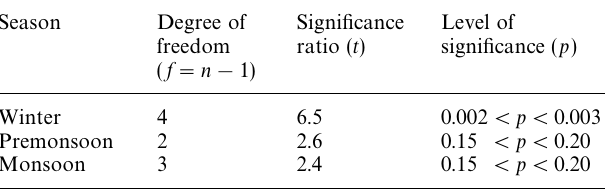
Table 8. Significance ratio ( t ) and level of significance ( p ) Season Degree of Significance Level of freedom ratio ( t ) significance ( p ) ( f " n ! 1) Winter 4 6.5 0.002 ( p ( 0.003 Premonsoon 2 2.6 0.15 ( p ( 0.20 Monsoon 3 2.4 0.15 ( p (